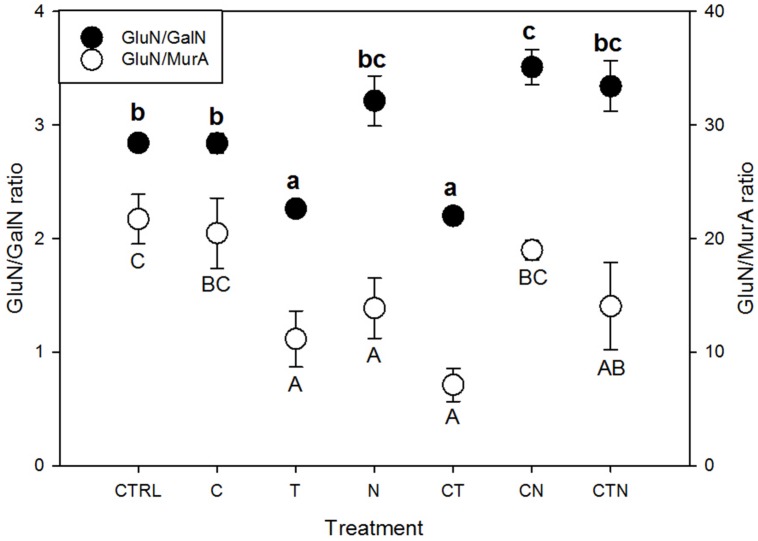
Amino sugar ratios under single and combined global change treatments. CTRL, control; C, elevated CO2; T, elevated temperature; N, nitrogen deposition; GluN, glucosamine; GalN, galactosamine; MurA, muramic acid. Bars indicate SE of the mean (n = 4 or 5). Dots sharing a letter are not significantly different (P = 0.05, LSD test).